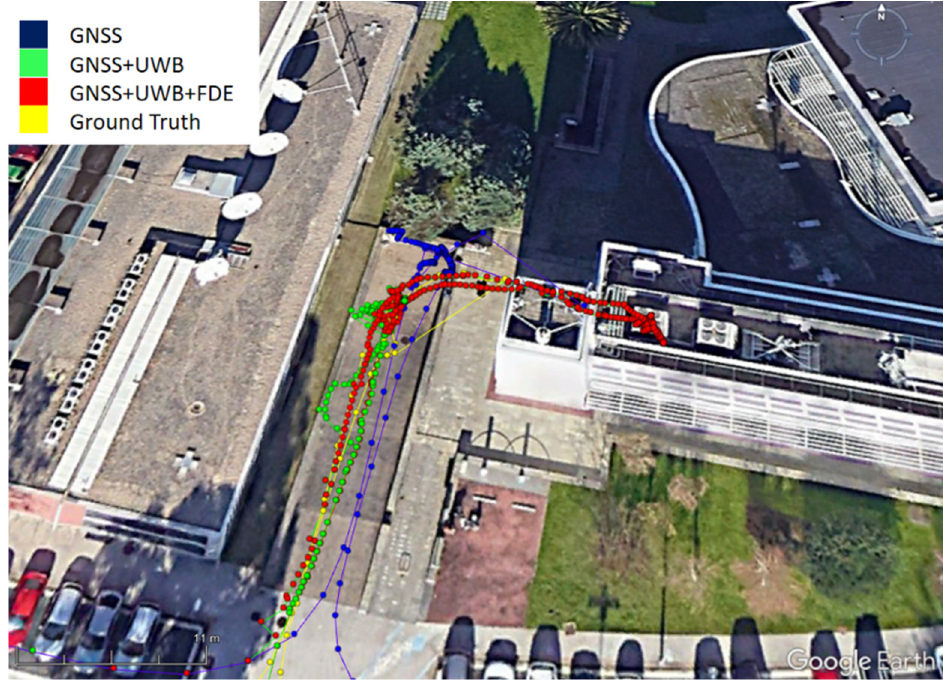
Figure 9. Qualitative comparison of the results against the ground truth (round 5).